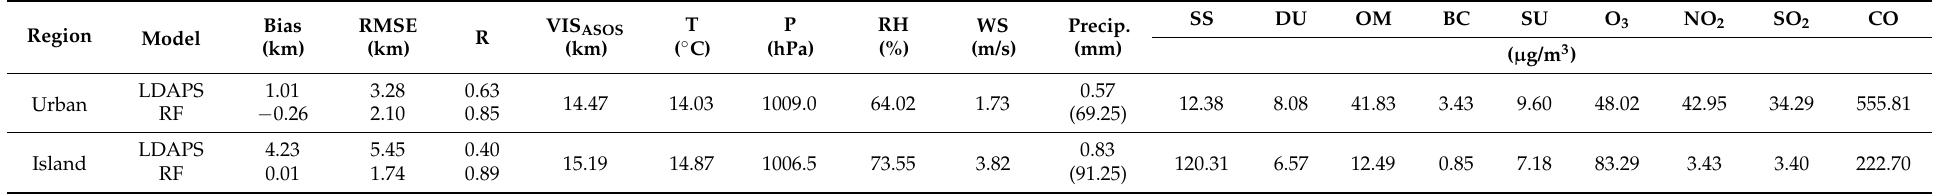
Table 4. Correlation coefficients (R) between VIS RF and meteorological variables. Values in parentheses are the correlation coefficients between VIS ASOS and the meteorological variables. Region T RH P Precip. WS SS DU OM BC SU O 3 NO 2 SO 2 CO − 0.03 Urban (0.10) − 0.37 Island ( − 0.33)